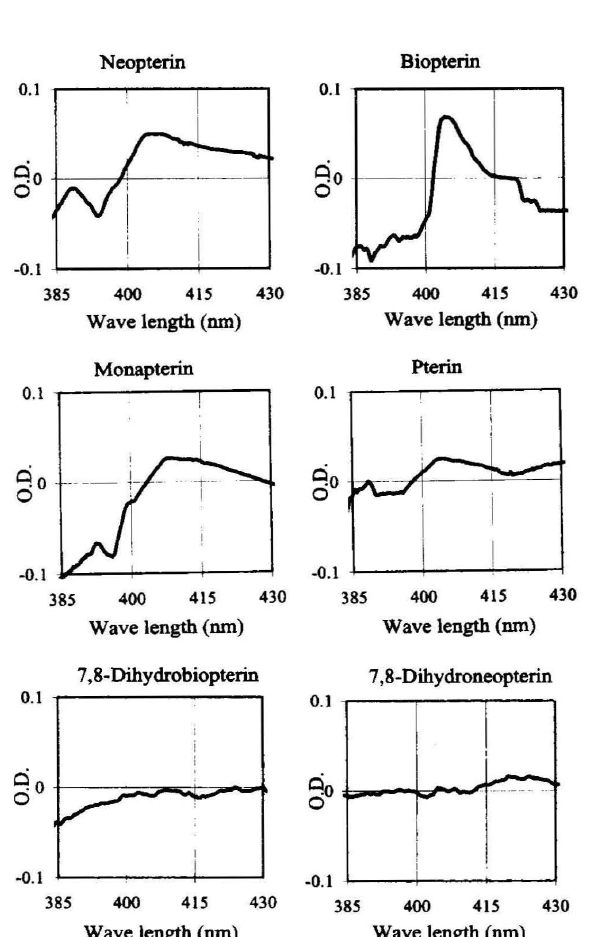
Figure 3. Difference spectra demonstrating the interaction of the active site of the cytochrome P450 system and pter